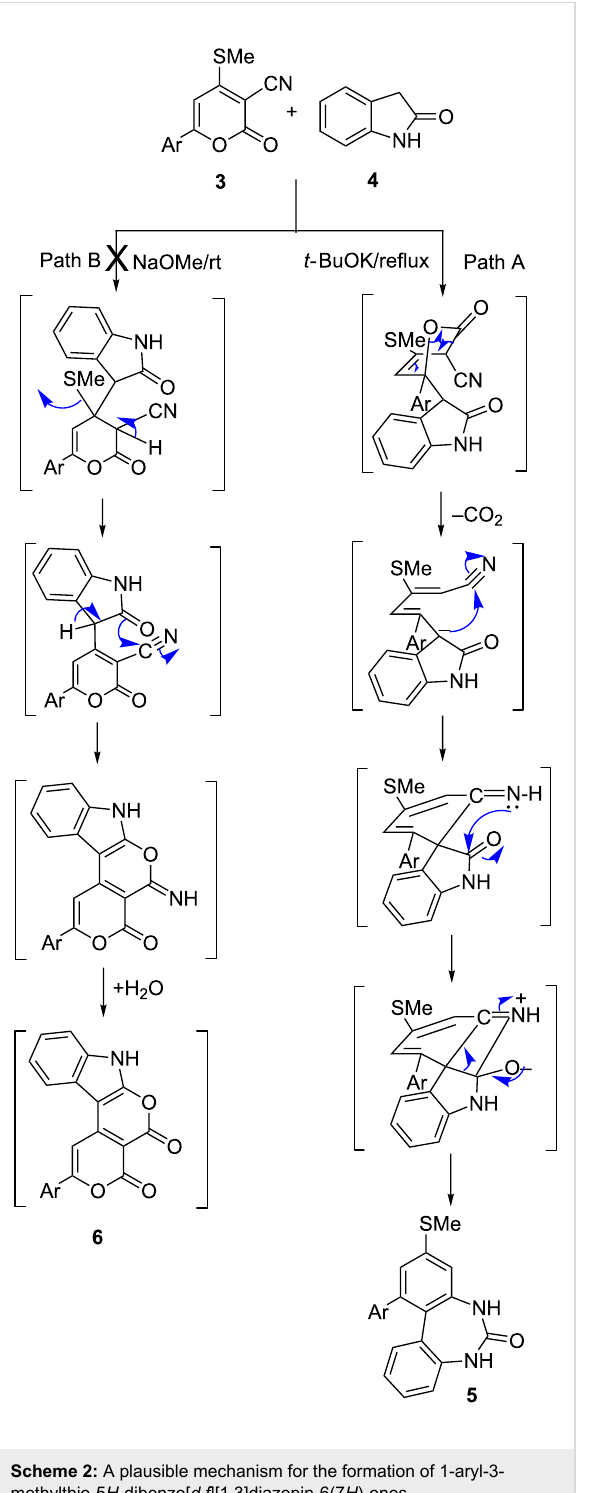
undergoing further cyclization to yield either 6 or 7 , possibly due to the lower dielectric constant of THF (7.42) compared to methanol (32.7) (Scheme 3).